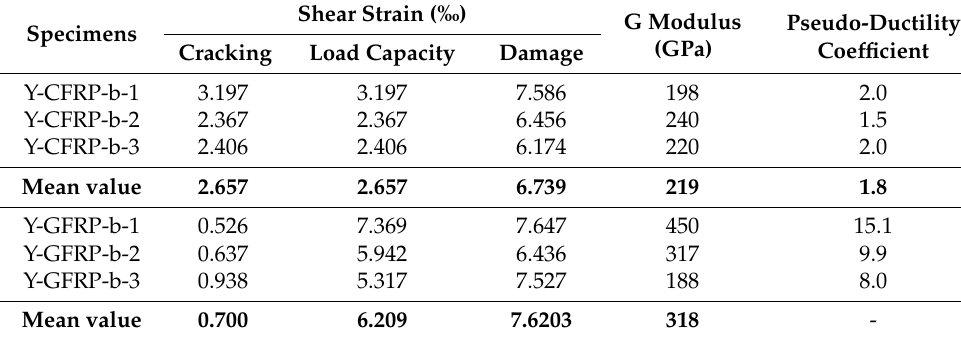
Table 8. Deformation parameters characterizing the walls strengthened in configuration